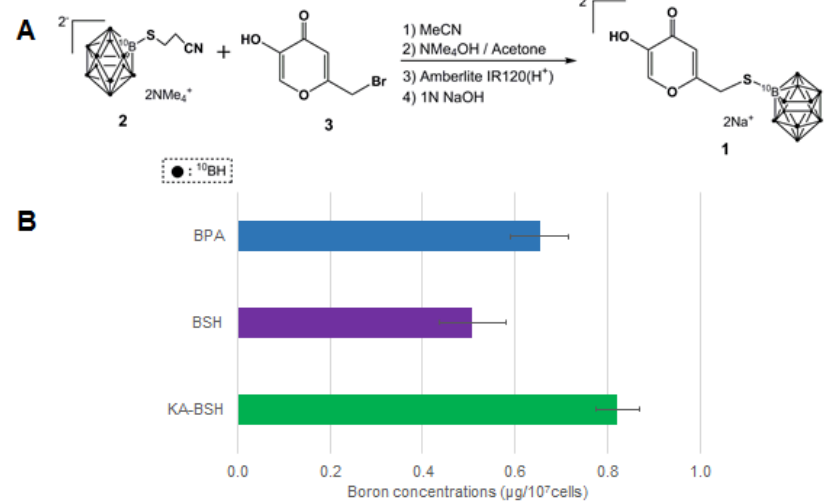
Figure 1. ( A ) The synthesis scheme of KA-BSH. ( B ) 10 B concentration of F98 rat glioma cells 24 h after incubation in DMEM, including 1 mM of each boron compound. The 10 B concentrations of tumor cells were significantly higher in the KA-BSH group than the BSH group (0.821 ± 0.047 vs. 0.508 ± 0.072 µ g 10 B / 10 7 cells; p = 0.0008) and BPA group (0.821 ± 0.047 vs. 0.654 ± 0.062 µ g 10 B / 10 7 cells; p =